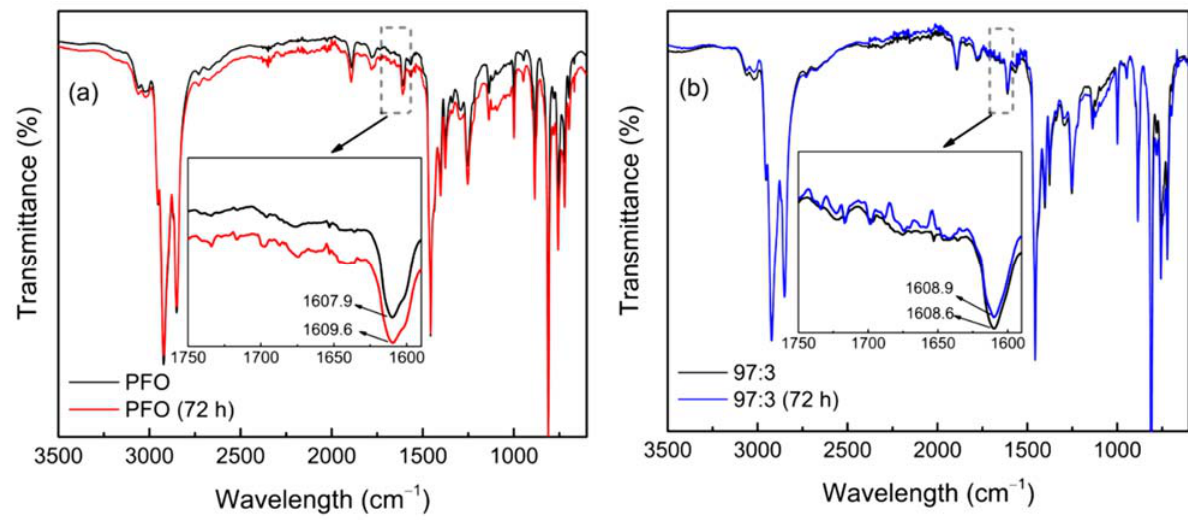
Figure 7. FTIR spectra of ( a ) pristine PFO films and ( b ) aggregated PFO films before and after thermal degradation test, respectively.